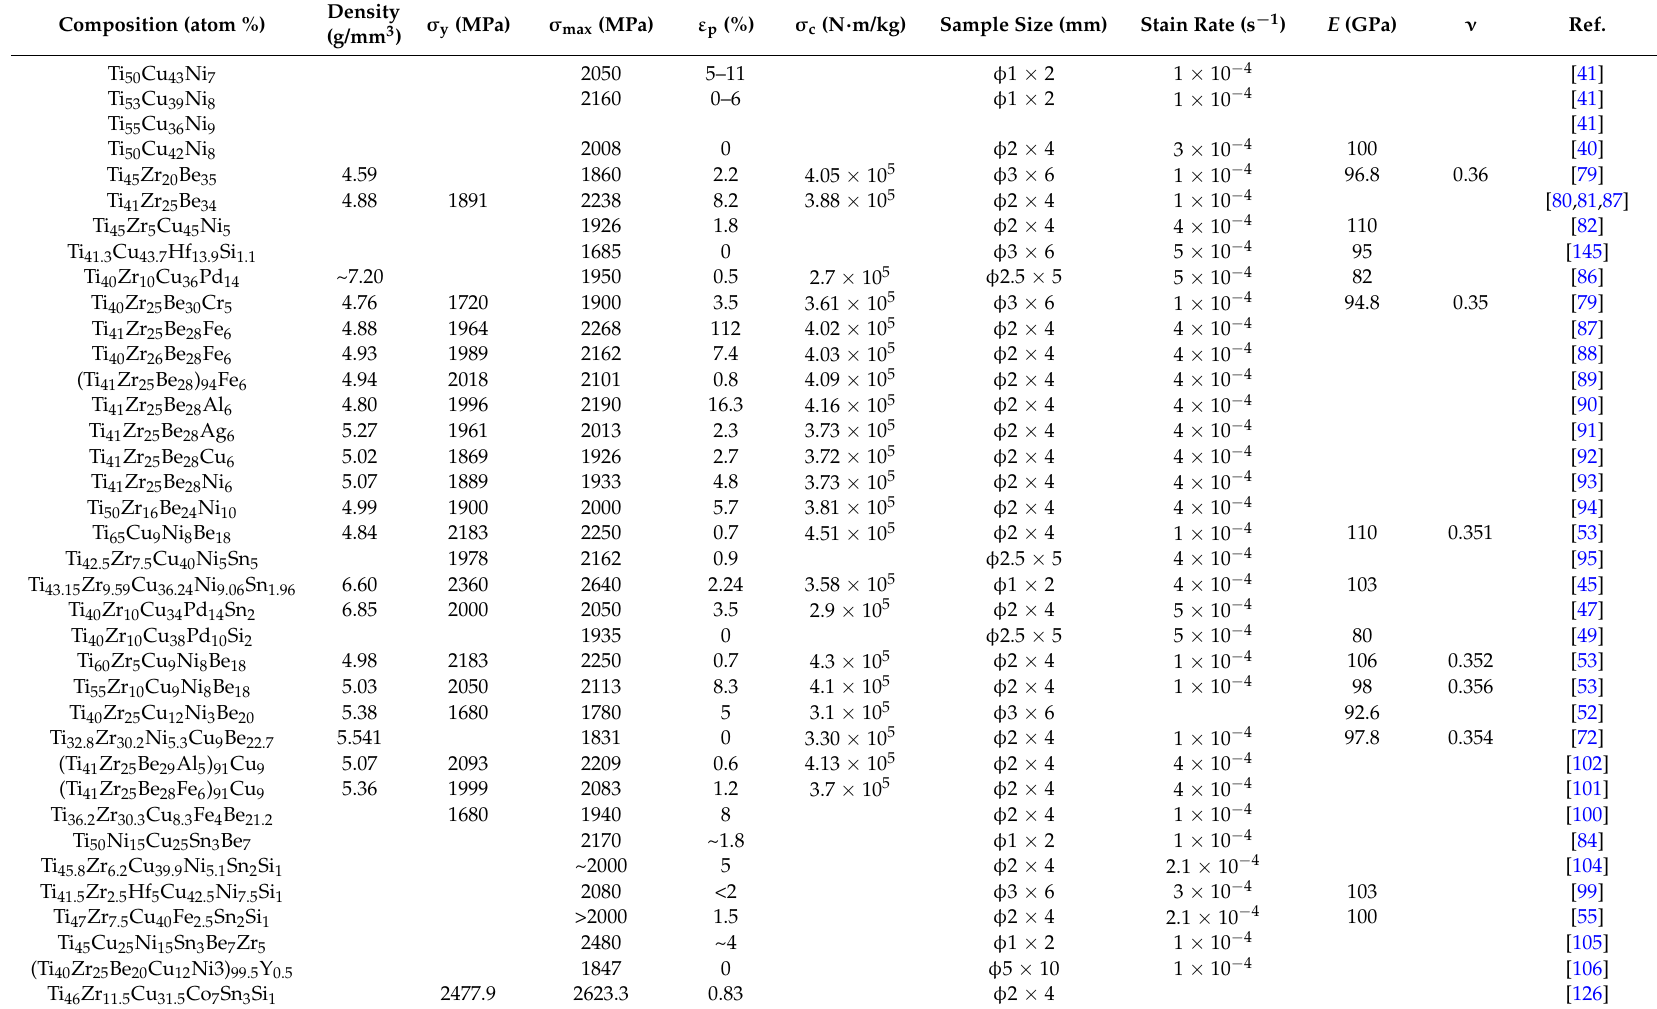
Table 4. Mechanical properties of typical Ti-based BMGs together with other BMGs and crystalline alloys [40,41,45,47,49,52–57,72,79–82,84,86–95,99–106,110,126,145–147]. Composition (atom